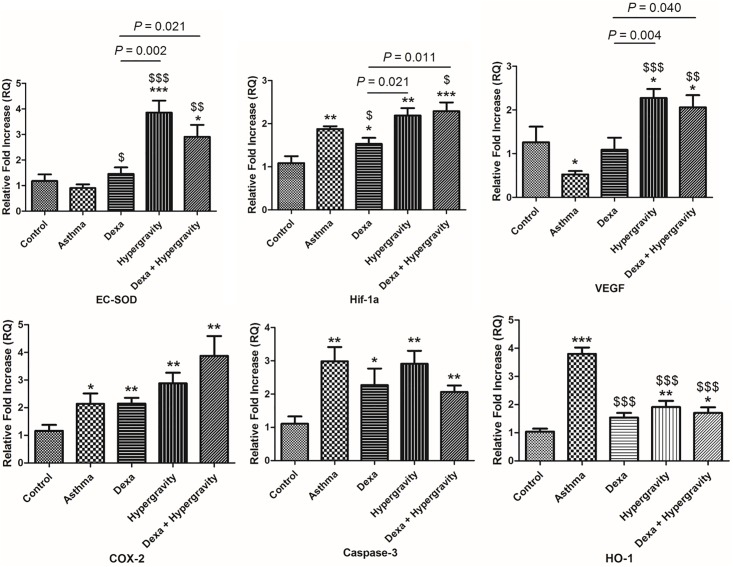
Expression of extracellular superoxide dismutase (EC-SOD), Hypoxia-inducible factor-1α (Hif-1α), Vascular endothelial growth factor (VEGF), Cyclo-oxygenase-2 (COX-2), caspase-3, and heme oxygenase-1 (HO-1) genes, evaluated by real-time PCR.* Significant difference from the control group, p < 0.05; ** significant difference from the control group, p < 0.01; *** significant difference from the control group, p < 0.001; $ significant difference from the asthma group, p < 0.05; $ $ significant difference from the asthma group, p < 0.01; $ $ $ significant difference from the asthma group, p < 0.001 (the Kruskal-Wallis and Mann-Whitney U tests).